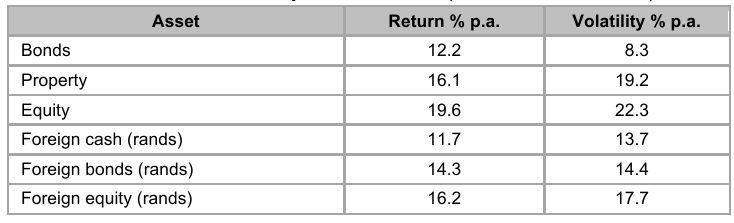
Returns and risks of major asset classes (Jan 1971 to Dec 2010) Asset Return % p.a. Volatility % p.a.